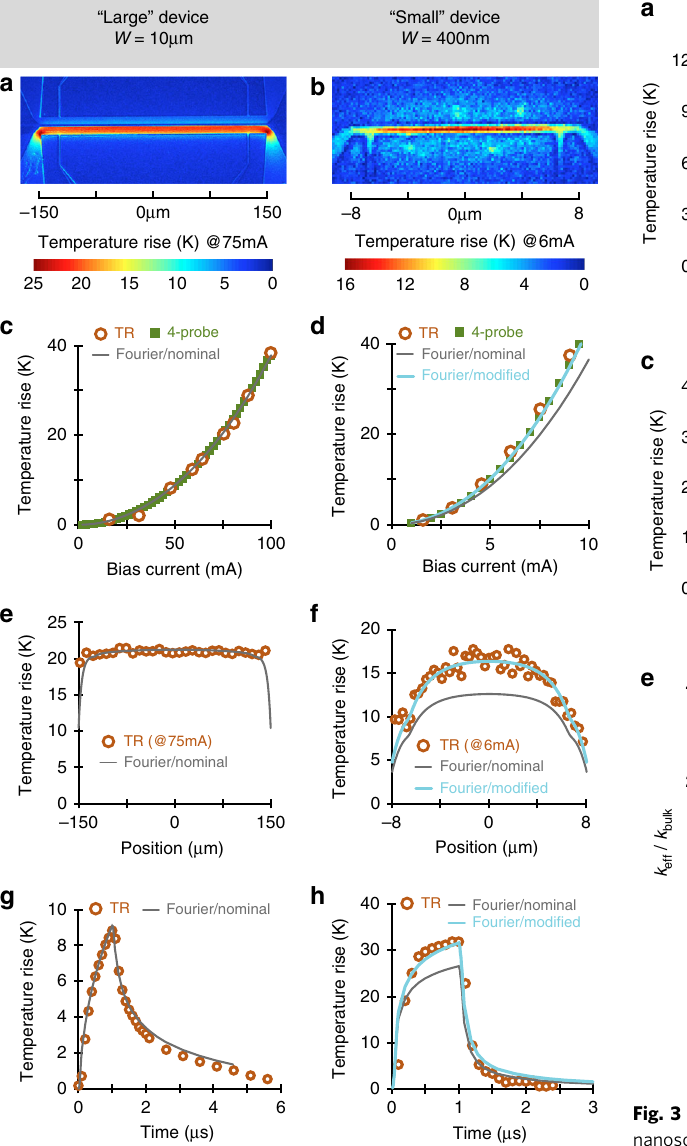
Fig. 2 Characterisation of thermal performance at the active junction. Thermore fl ectance thermal images of a a 10 μ m; and b a 400nm heater lines. The average device temperature on top of the devices for c 10 μ m; and d 400nm heater lines. The thermore fl ectance, electrical (IVT) and FEM results are plotted as a function electrical current. FEM results with nominal value of thermal conductivity for InGaAs (5.4 W m − 1 K − 1 ) agrees with the experimental results at 10 μ m, whereas a smaller number (4.2 W m − 1 K − 1 ) is needed to match the data for 400 nm device. Comparison of TR and FEMs ’ longitudinal temperature cross sections along e 10 μ m; and f 400 nm heater lines. Comparison of maximum transient temperature on top of the heater line using TRI and FEM: g 10 μ m; and h 400 nm heater lines. A 1 μ s current pulse with 5% duty cycle was applied to the heater and the temperature pro fi le was recorded every 100 ns. The average temperature near the centre of the line is compared to that of obtained from FEM. Marked agreement between the FEM model using nominal value of thermal conductivity (5.4 W m − 1 K − 1 ) and the experiment in all of the results for 10 μ m heater line is evident. The measured self-heating in small devices clearly exceeds nominal predictions but can still be fi tted to diffusive simulations with reduced InGaAs thermal conductivity (4.2 W m − 1 K − 1 instead of 5.4 W m − 1 K − 1